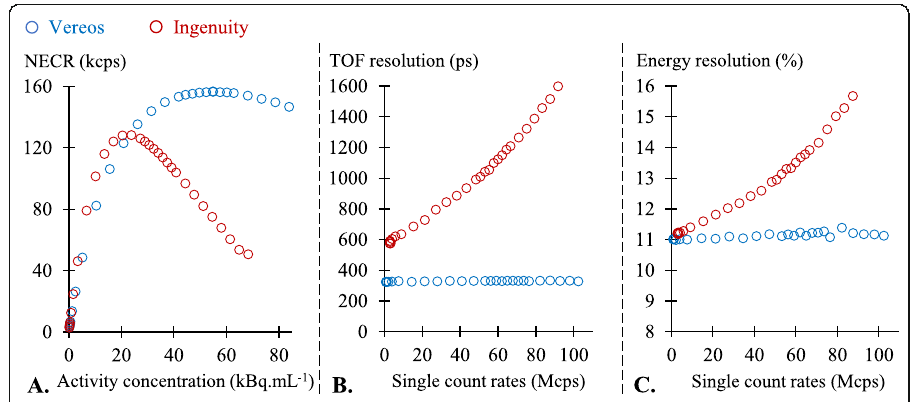
Fig. 1 Results obtained from the NEMA count-rate test for the Ingenuity (red) and the Vereos (blue) cameras, with the relationships between noise equivalent count rates and activity concentration (NECR) ( a ) and with the relationships between TOF ( b ) or energy ( c ) resolutions and single-count